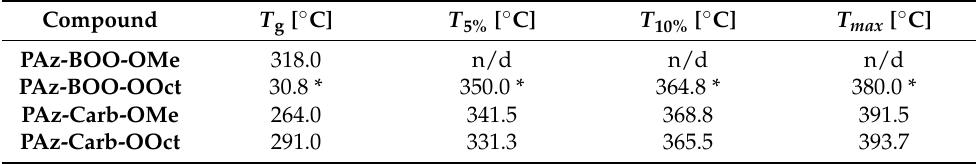
Table 3. Thermal properties of synthesized polymers. Compound